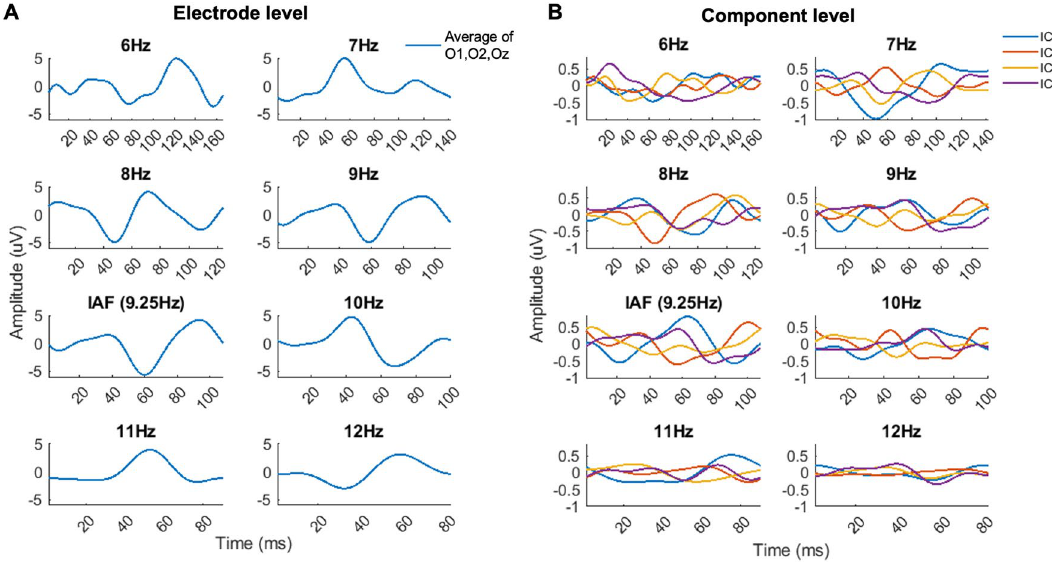
Figure 4. Electrode versus component level SSVEPs for one subject. (Panel A ). Electrode level. The average SSVEP across electrodes O1, O2 and Oz are shown for each rhythmic flicker frequency condition. (Panel B ). Component level. The SSVEP for each of the four components for this subject are shown for each of the rhythmic flicker frequency